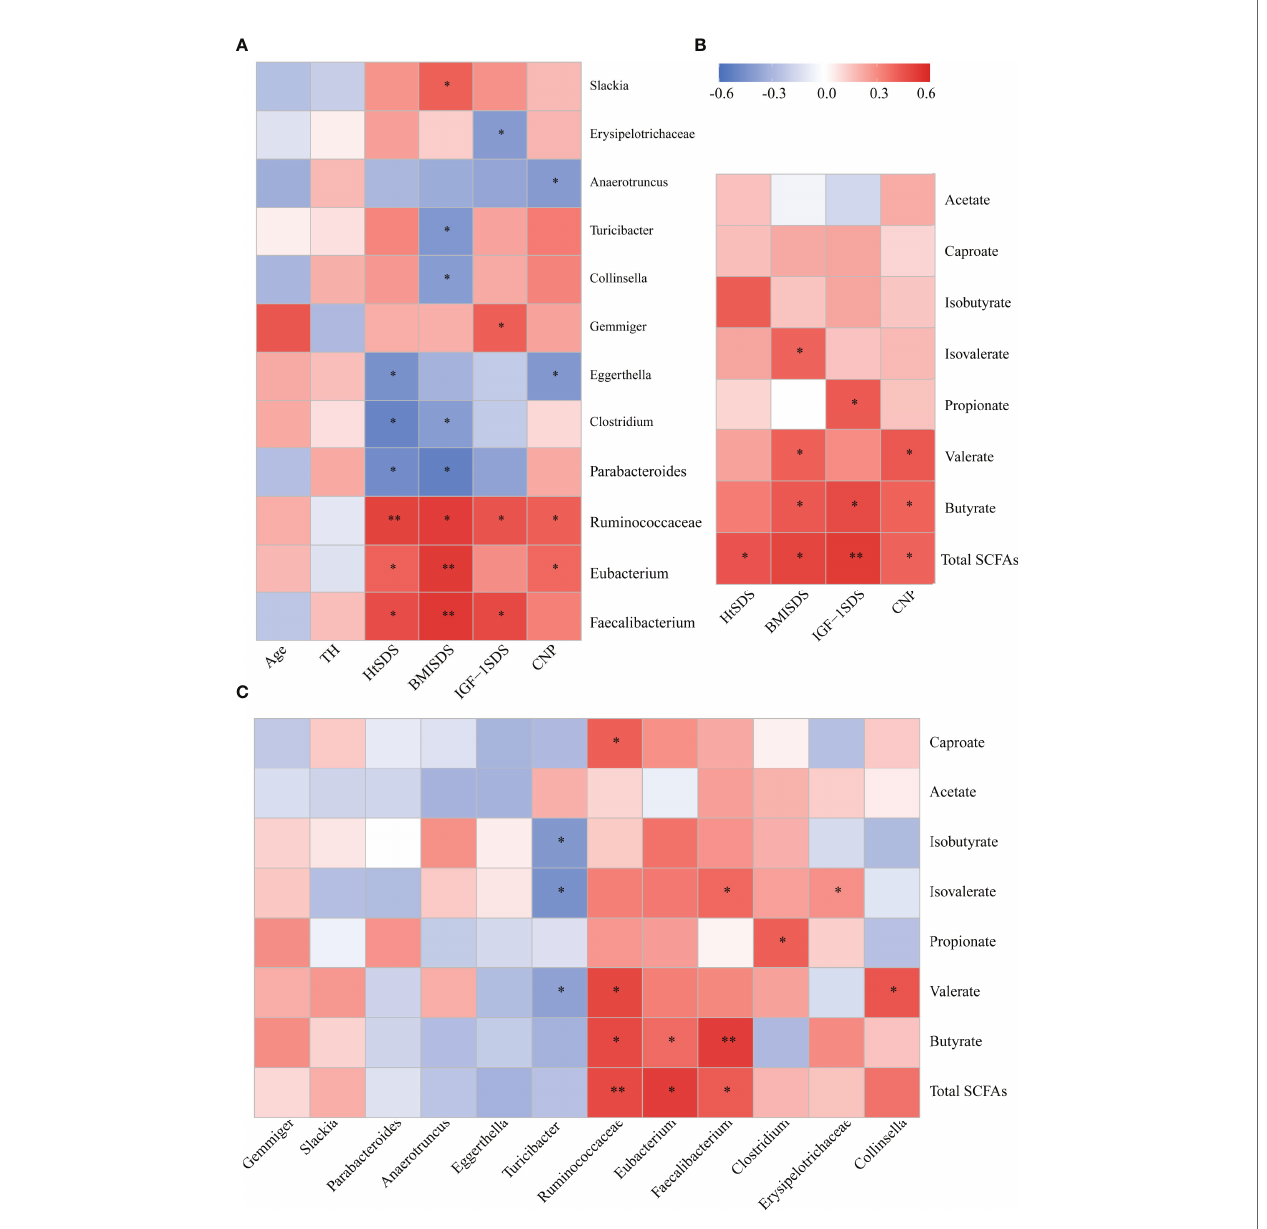
FIGURE 5 | (A) Associations of gut microbial taxa with clinical indexes. Heat map of Spearman ’ s rank correlation coef fi cient among six clinical indexes and 12 taxa; (B) A heatmap of Spearman correlation between clinical indexes and SCFA; (C) A heatmap of Spearman correlation between gut microbiota and SCFAs. Red: positive correlation; blue: negative correlation; * P < 0.05, ** P < 0.01. SCFAs, short-chain fatty